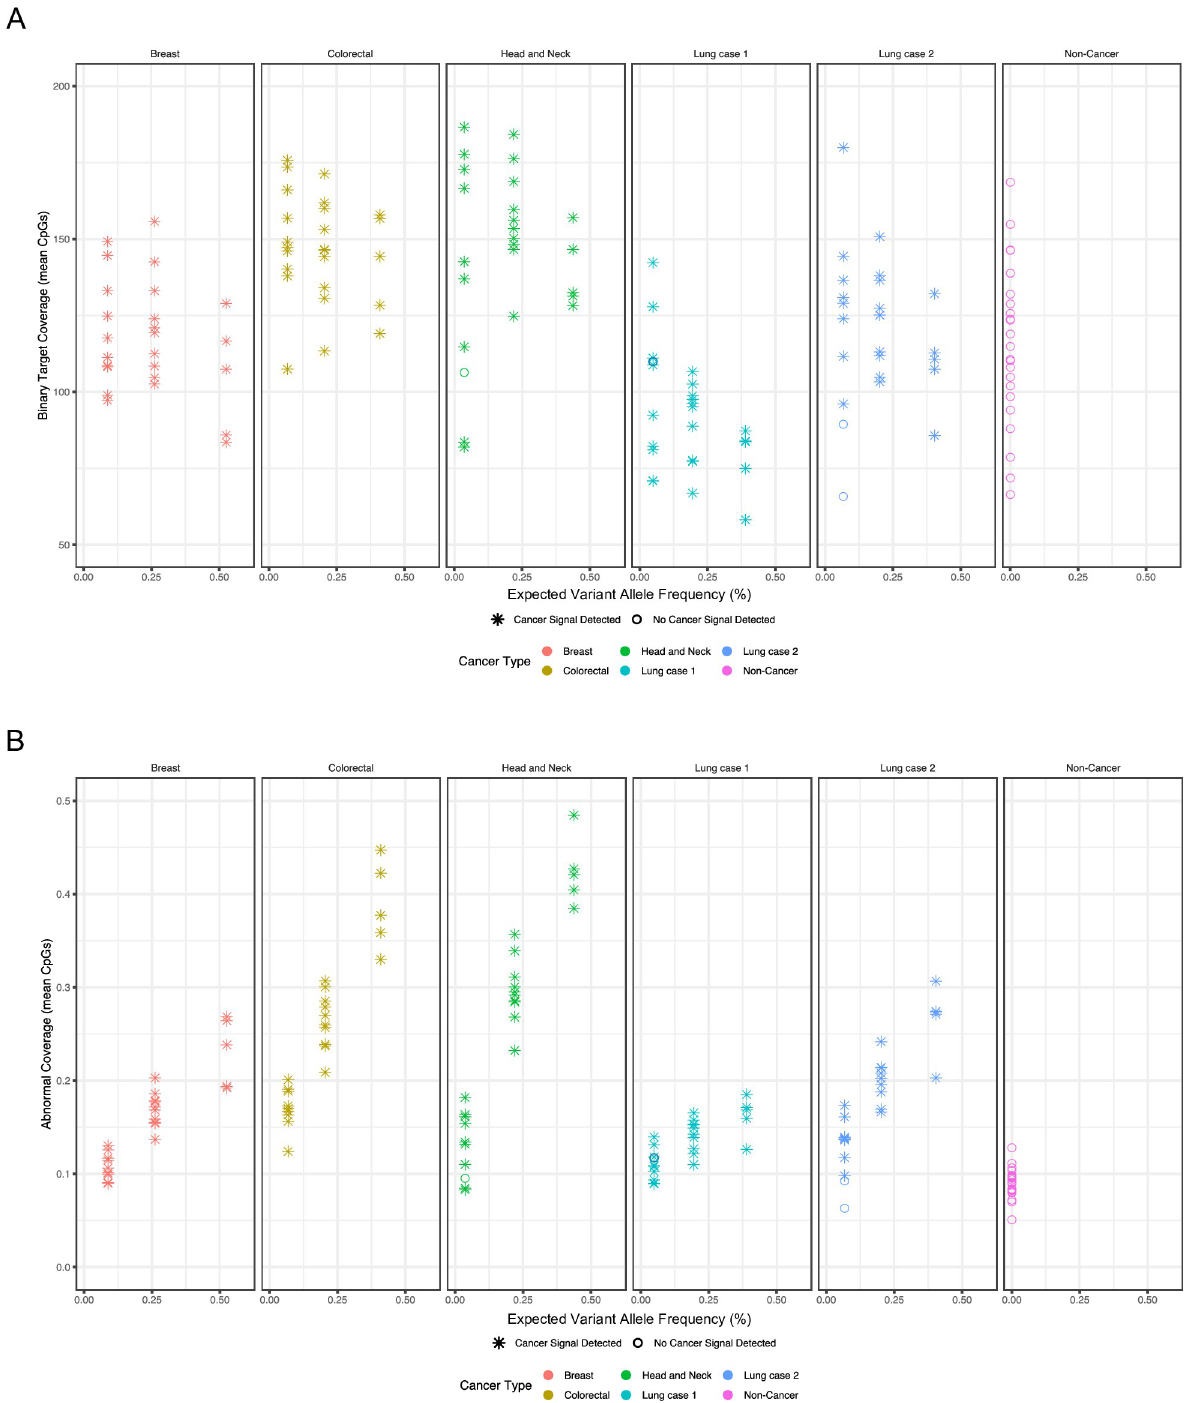
Fig 3. Binary target coverage is not correlated with variant allele frequency while abnormal coverage is correlated with variant allele frequency. (A) Binary target coverage, which quantifies the coverage of methylation regions in cell-free DNA (cfDNA) fragments that are not affected by cancer, is a measure of the baseline performance of the multi-cancer early detection test. Binary target coverage is not affected by tumor content of admixtures (proportion of cfDNA fragments with variants identified in samples with matched tumor biopsy samples) in breast cancer (red), colorectal cancer (olive), head and neck cancer (green), and lung cancer (teal and blue) samples, similar to non-cancer samples (magenta). Samples with a cancer signal detected or not detected are indicated by asterisks or open circles, respectively. (B) Abnormal coverage is correlated with variant allele frequency (proportion of cfDNA fragments with variants identified in samples with matched tumor biopsy samples) in breast cancer (red),